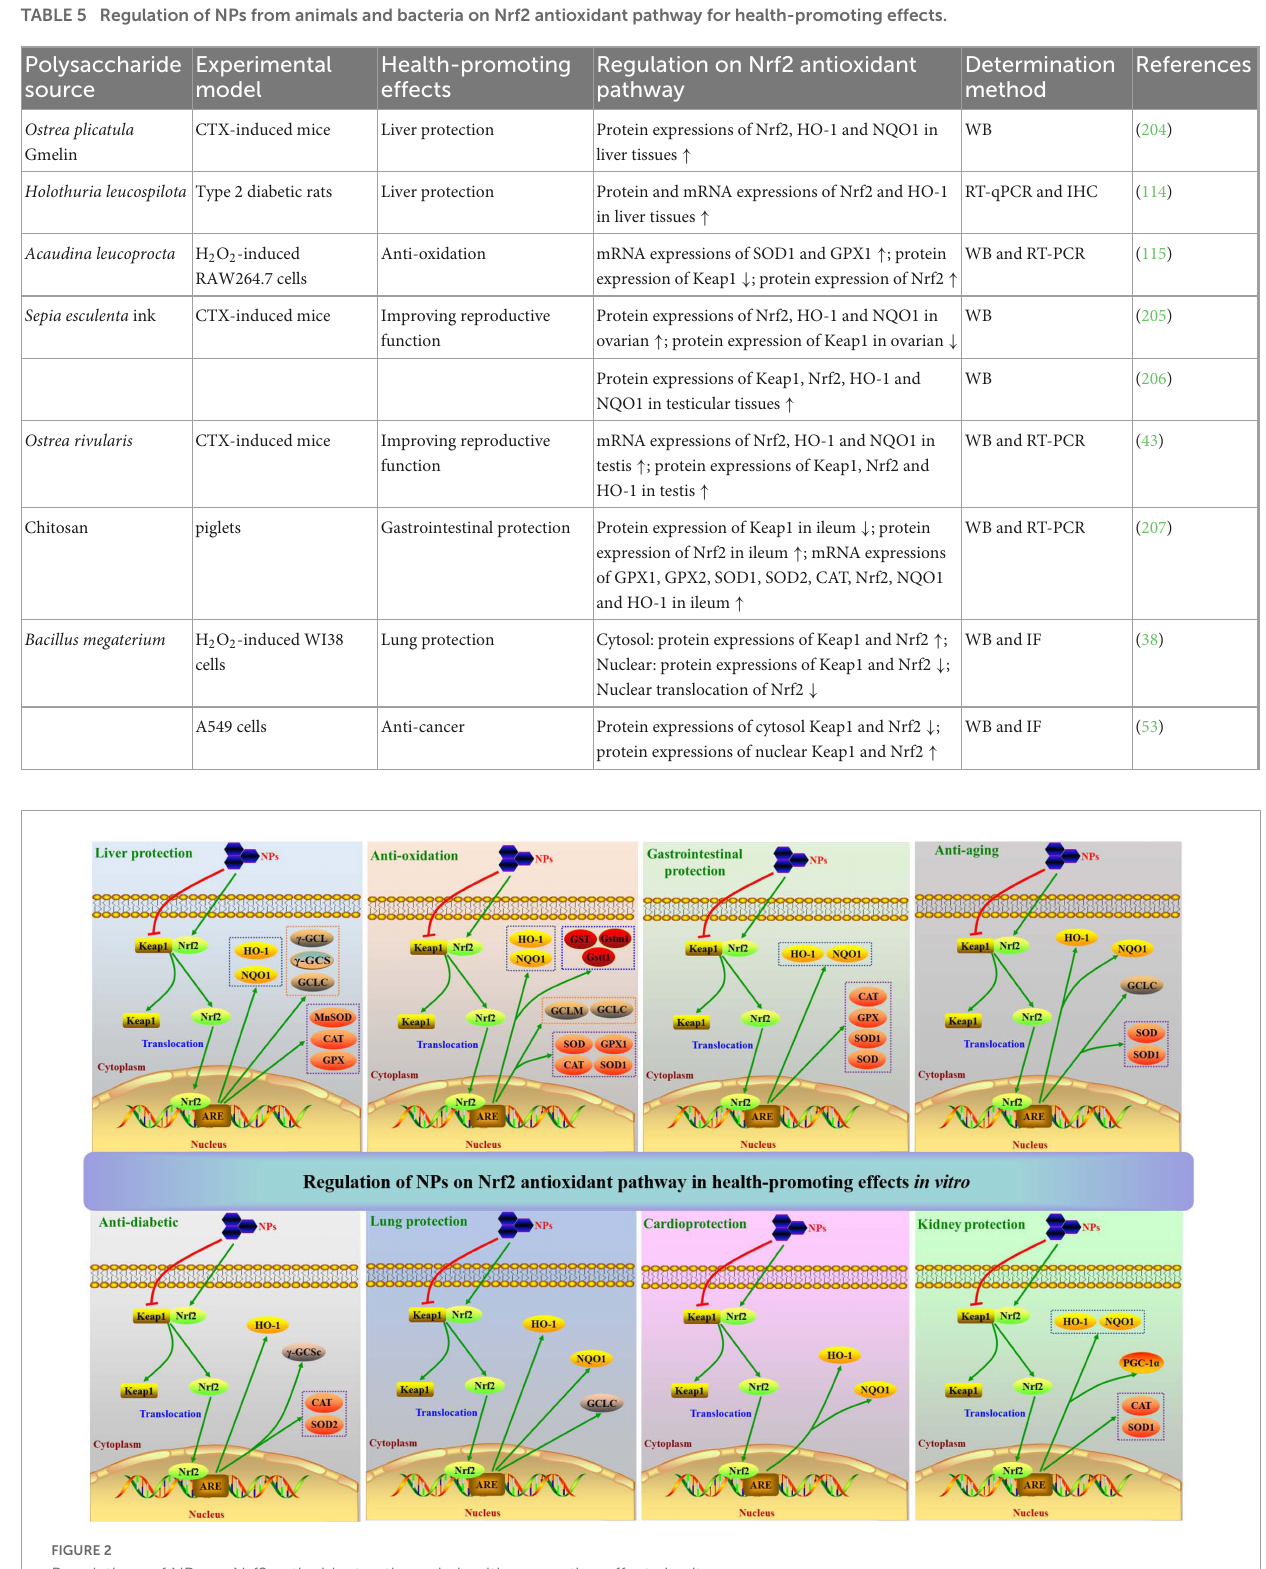
FIGURE2 Regulations of NPs on Nrf2 antioxidant pathway in health-promoting effects in vitro .